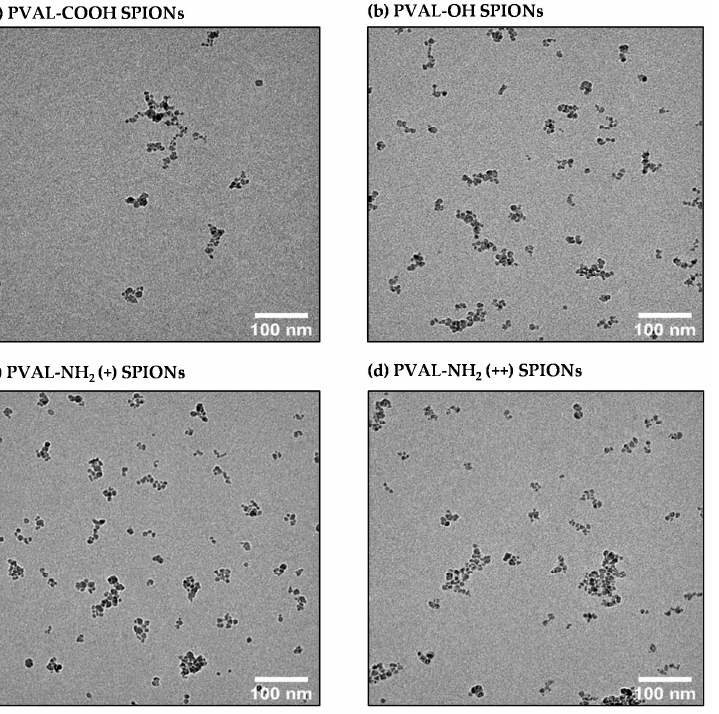
Figure 4. TEM micrographs of ( a ) PVAL-COOH SPIONs, ( b ) PVAL-OH SPIONs, ( c ) PVAL-NH 2 (+) SPIONs and ( d ) PVAL-NH 2 (++) SPIONs.